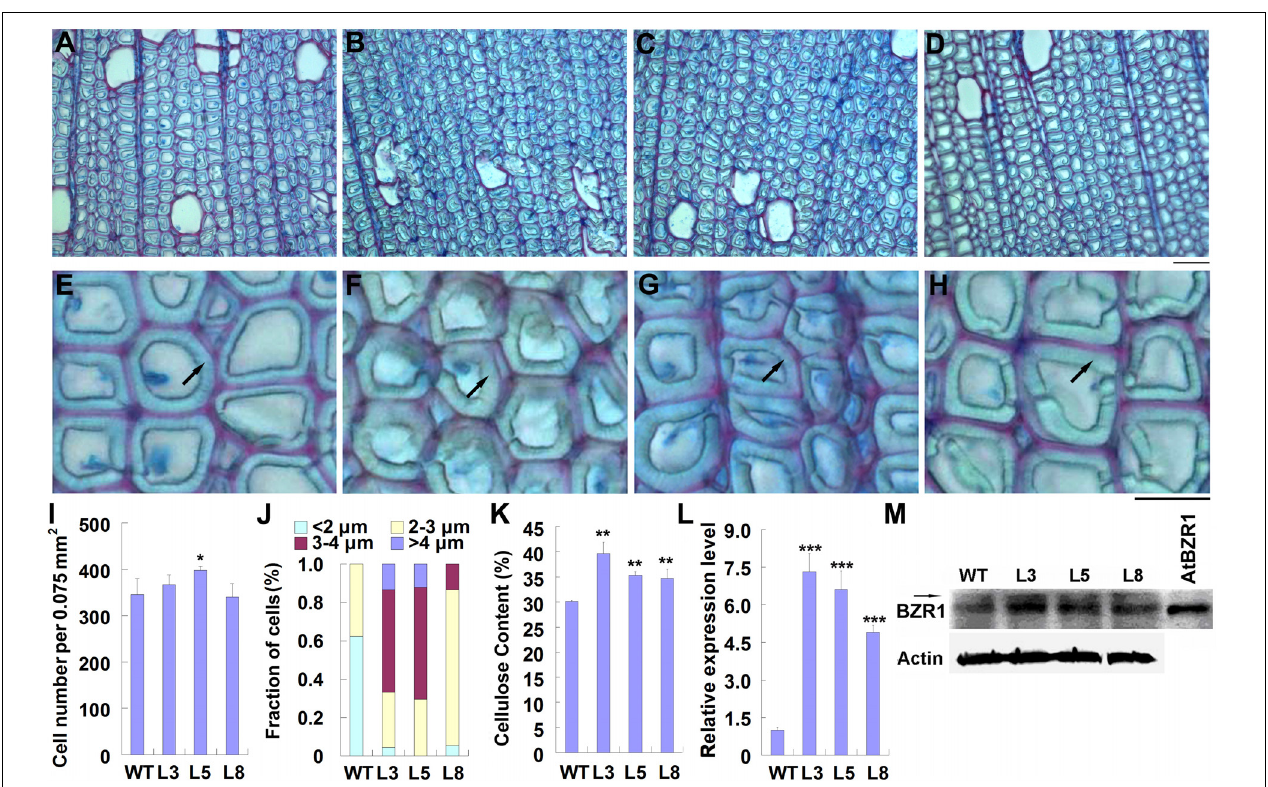
FIGURE 3 | Overexpression of PtiCYP85A3 prompted gelatinous-layer (G-layer) formation in the TW xylem fiber cells of Shangxin yang plants. (A–D) Images to show the gelatinous layer in the TW xylem fiber cells of wild type (WT) (A) and transgenic lines L3 (B) , L5 (C) , and L8 (D) . G, G-layer. Bar = 15 µ m. (E–H) Higher magnification of the images in (A–D) , respectively. (I–K) Cell number per area (I) , fraction of cells with different G-lay thicknesses (J) , and cellulose content (K) in the TW xylem of WT and different transgenic lines. Data were means ± SD ( n = 3) of three independent biological replicates. For analyses with different G-lay thicknesses in (J) , 300 cells were counted ( n = 300). (L) The expression levels of PtiCYP85A3 in the TW xylem of WT and different transgenic lines. Data were means ± SD ( n = 3) of three independent biological replicates. (M) Western blotting analyses of BZR1 protein in the TW xylem of WT and different transgenic lines. A total amount of 40 µ g proteins extracted from the TW xylem were separated on 10% SDS-PAGE and hybridized with OsBZR1 antibodies (Anti-BZR1) or plant actin antibodies (Anti-Actin). The putative phosphorylated band of BZR1 was indicated with an arrow. M, protein molecular weight marker; WT, wide type Shangxin yang; L3, L5, and L8, different transgenic lines; AtBZR1, proteins from the leaf protoplasts overexpressing AtBZR1 . *, **, and *** indicate significant difference at P < 0.05, P < 0.01, and P < 0.001, respectively (Student’s t